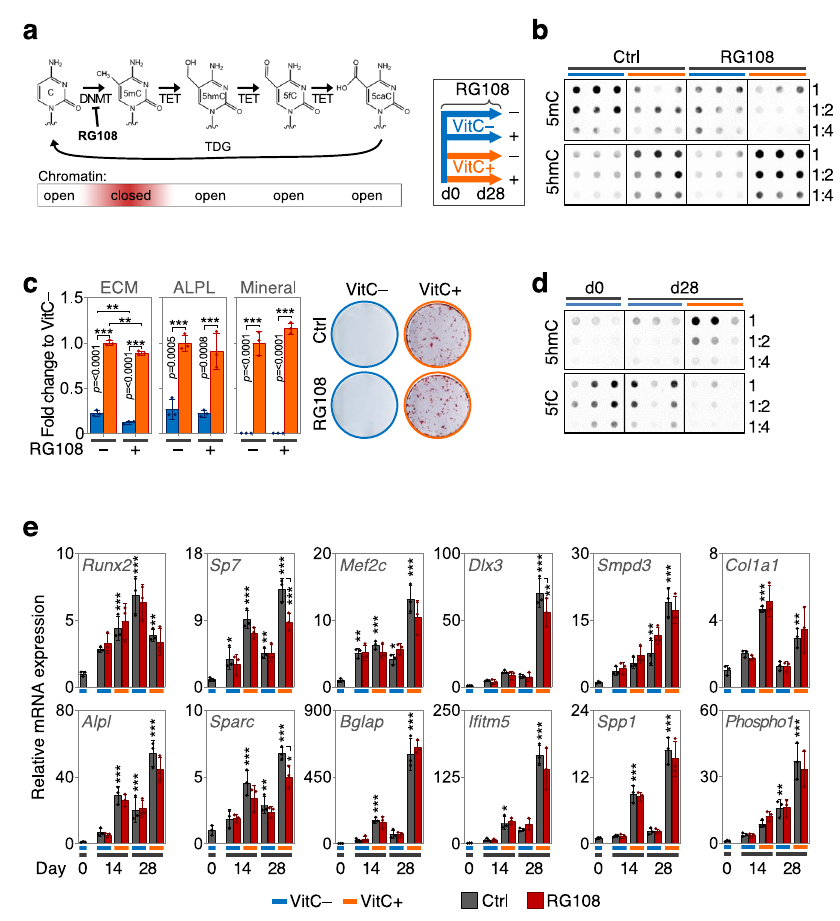
Fig.9|VitaminC-induced5hmCisastableepigeneticmarkthatisrequiredfor osteogenic differentiation. a Schematic representation of the active DNA deme- thylation cycle and experimental design for the shown experiments in differ- entiatingosteoblasts. b Dotblotsatday14withandwithoutVitCand/ortheDNMT- inhibitor RG108, which decreases global CpG methylation levels (5mC). c ECM deposition, alkaline phosphatase activity (ALPL) and ECM mineralization in the presence or absence of VitC and/or RG108. d Dot blots for 5hmC and 5fC (formyl- cytosine)inosteoblastsatindicatedtimepointsinthepresenceorabsenceofVitC.